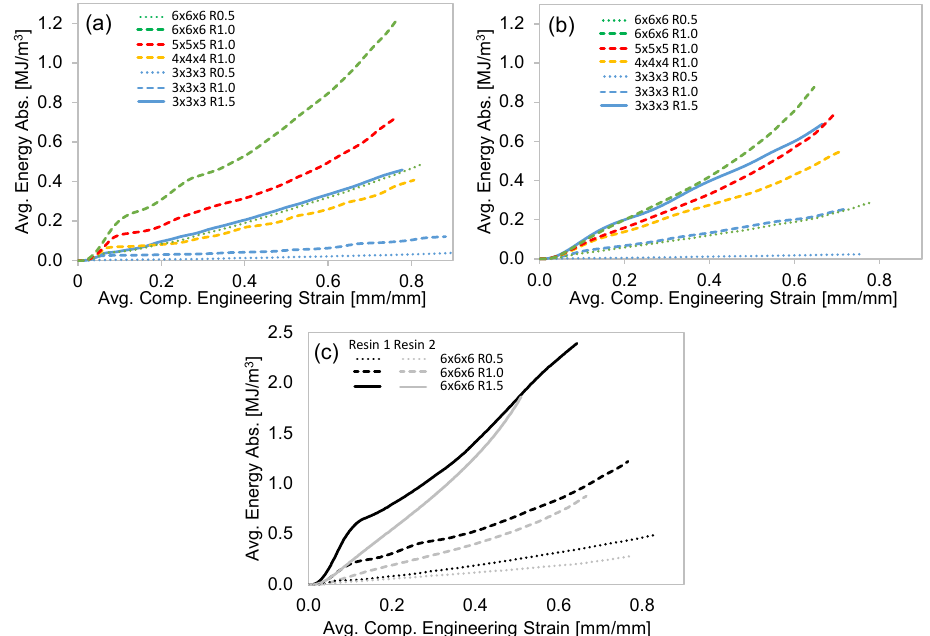
Figure 8. The average compression EA curves for all the lattice samples: ( a ) the results for Resin 1; ( b ) the results for Resin 2; ( c ) a comparison of the Resin 1 and 2 results for the 6 × 6 × 6 lattice structures. All curves terminate at the point of densification.